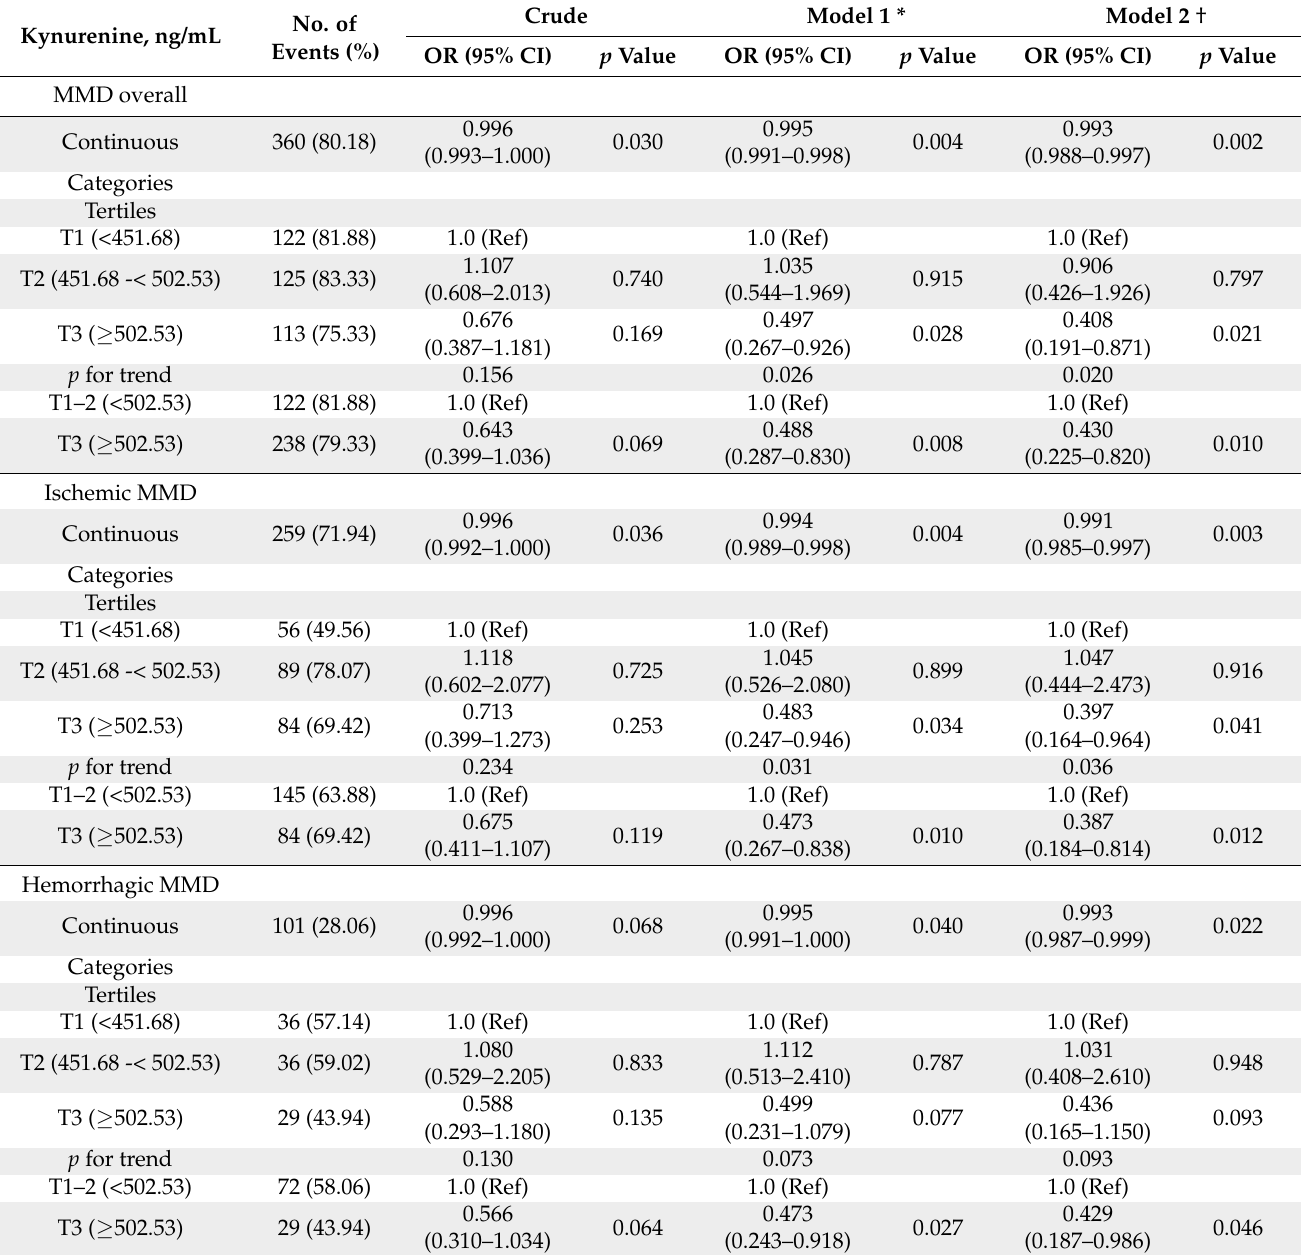
Table 5. The association between kynurenine and the risk of